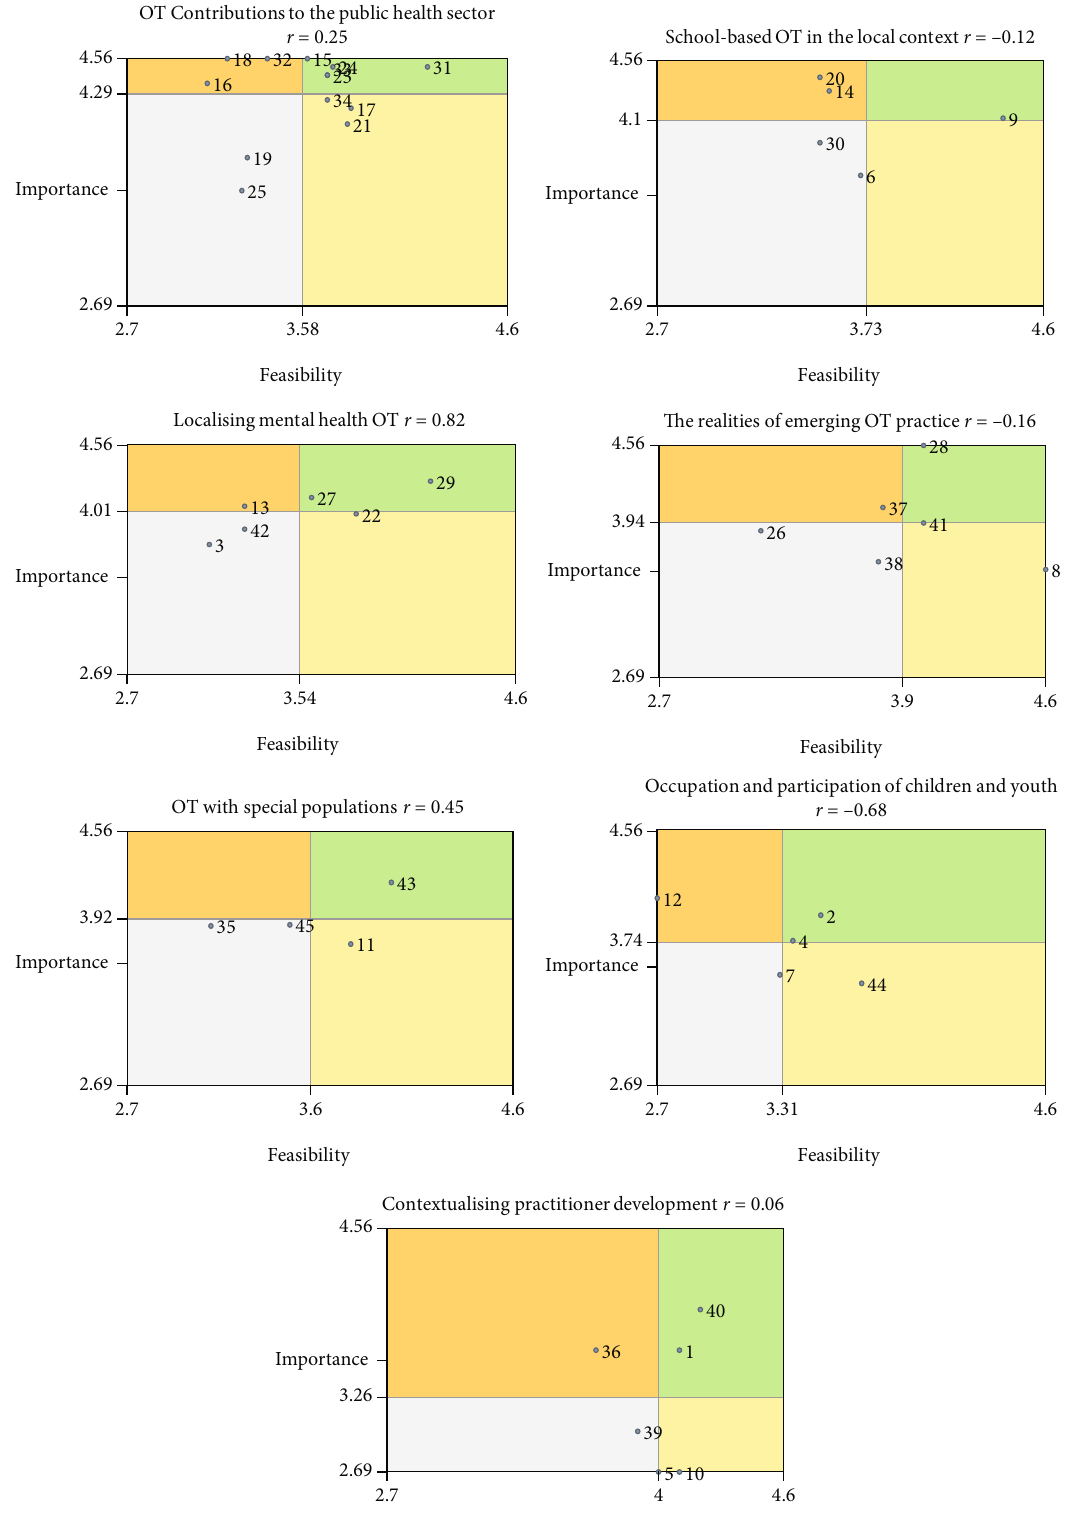
Figure 4: Go-zone plots for each of the seven clusters. Statements are represented as numbered points. The upper right quadrant of each plot, the “ go-zone ” , represents statements considered as research priorities while the upper left quadrant represents areas for future development. Importance ( n = 16 ); feasibility ( n = 11